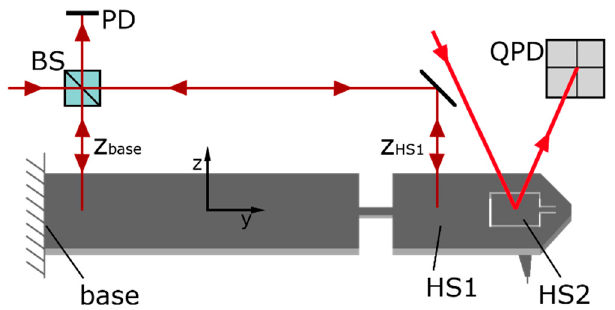
Figure 3. Abstract detection scheme of the 3D-Nanoprobe with a differential interferometer (beam splitter (BS), photodiode (PD)) to detect the displacement of HS1 z HS1 relative to the displacement of the base z base in the z-direction and a dual optical lever to detect a change in the inclination angle of bending angle α and torsion angle β of HS2 on the segmented quadratic photodiode (QPD).